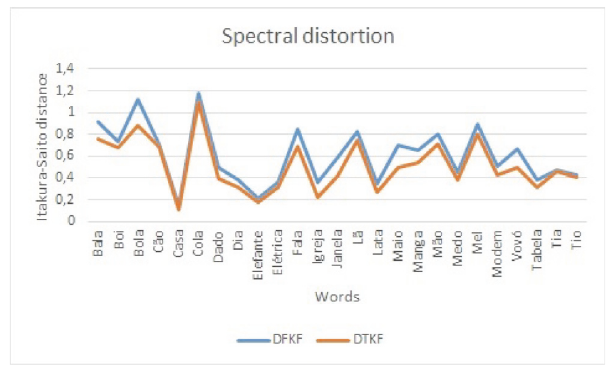
Figure 7: Comparison for spectral distortion for 25 words contami- nated by white noise with signal-to-noise ratio input (SNRI) of 3 dB.